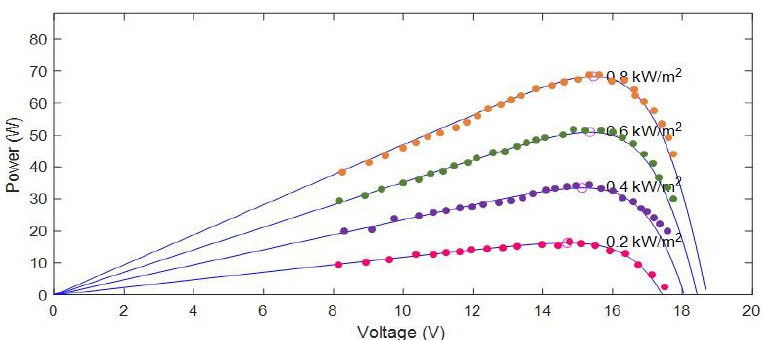
Figure 8. Comparison of the experimental and simulated data for the deep learning model.